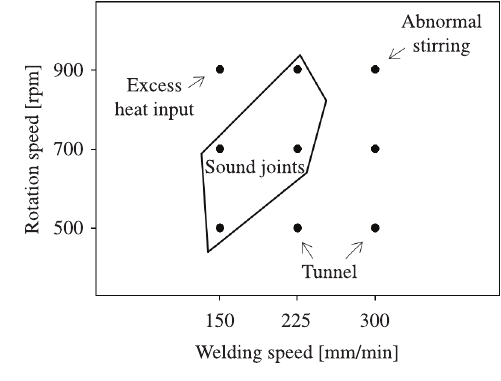
Figure 3. Experimental plan showing the combinations of process parameters; the boundary of sound joints is reported.